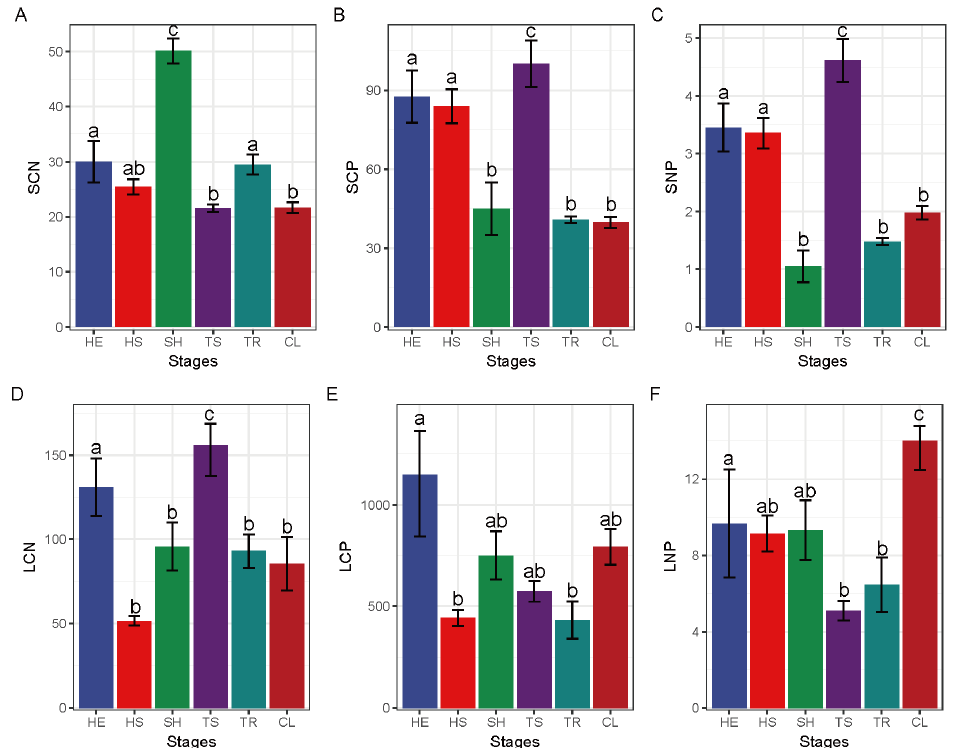
Figure 4. Changes in leaf and soil chemical properties at different restoration stages. SCN—soil C:N, SCP—soil C:P, SNP—soil N:P, LCN—leaf C:N, LCP—leaf C:P, LNP—leaf N:P; CL—Ultimate stage, TR—tree stage, TS—tree and shrub transition stage, SH—shrub stage, HS—grass and shrub transition stage, HE—herbaceous stage; different lowercase letters represent significant differences, p < 0.05. The different letters of a–c represent significant differences. The change characteristics of SCN ( A ), SCP ( B ), SNP ( C ), LCN ( D ), LCP ( E ) and LNP ( F ) in different recovery stages.